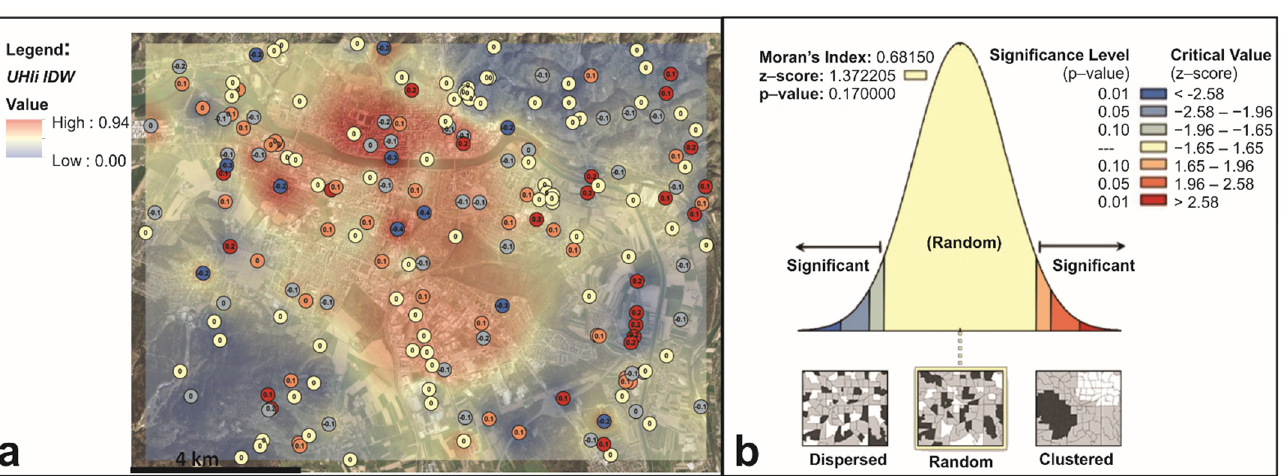
Figure 5. GAM model fitting. The IDW interpolated UHIi based on 190 random points (10 per UA category) with corre- sponding GAM model over- and under-predictions points with labels; ( a ) and Moran’s I statistics ( b ).